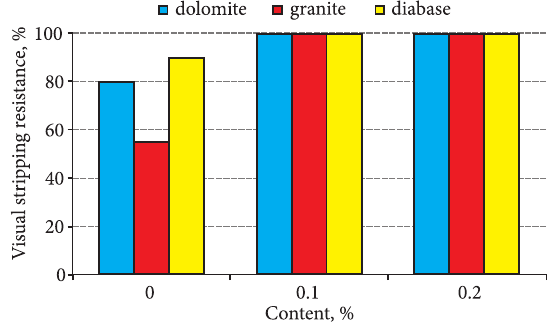
Fig. 5. Stripping resistance with bitumen B70/100 Nynas form Estonia containing polyphosphoric acid based